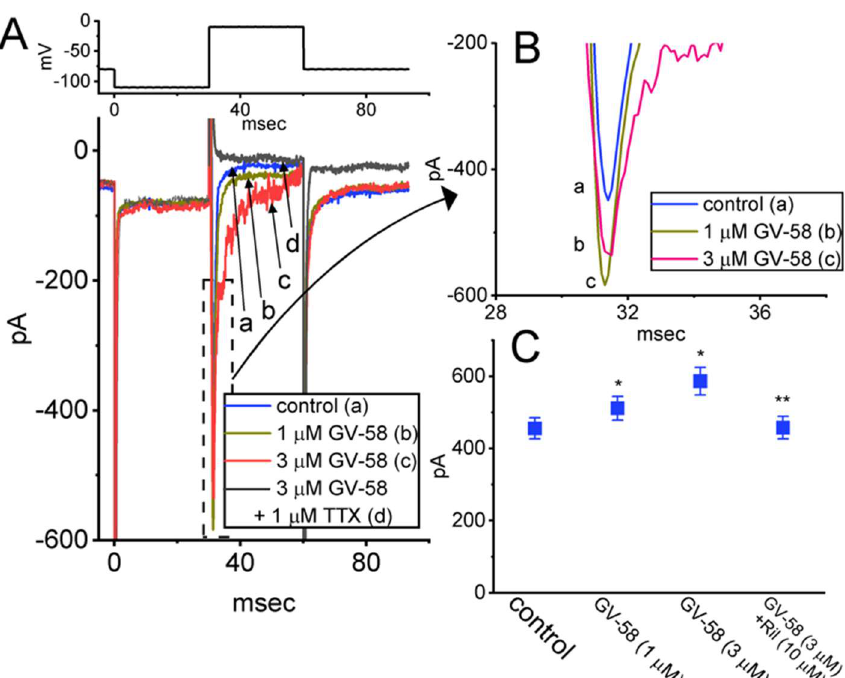
Figure 12. Effects of GV − 58 on I Na identified in NSC − 34 motor neuron − like cells. These experiments were undertaken in cells bathed in Ca 2+ − free Tyrode’s solution which contained 10 mM TEA and 0.5 mM CdCl 2 , while the recording pipettes that we prepared were filled up with Cs + − containing solution. ( A ) Representative I Na traces obtained in the control (a), during cell exposure to 1 μM GV − 58 (b) or 3 μM GV − 58 (c), and in the presence of 3 μM GV − 58 plus 1 μM TTX (d). The upper part in ( A ) depicts the voltage − clamp protocol applied. In ( B ), an expanded record showing I Na traces is taken from the dashed box in ( A ). ( C ) Summary graph showing effect of GV − 58 (1 or 3 μM) and GV − 58 (3 μM) plus riluzole (Ril, 10 μM). Current amplitude was taken at the beginning of depolarizing command voltage from −100 to −10 mV with a duration of 30 ms. Each bar indicates the mean ± SEM (n = 7). * Significantly different from control ( p < 0.05) and ** significantly different from the GV − 58 (3 μM) alone group ( p < 0.05). Statistical analyses were made in one − way ANOVA among different groups ( p < 0.05).